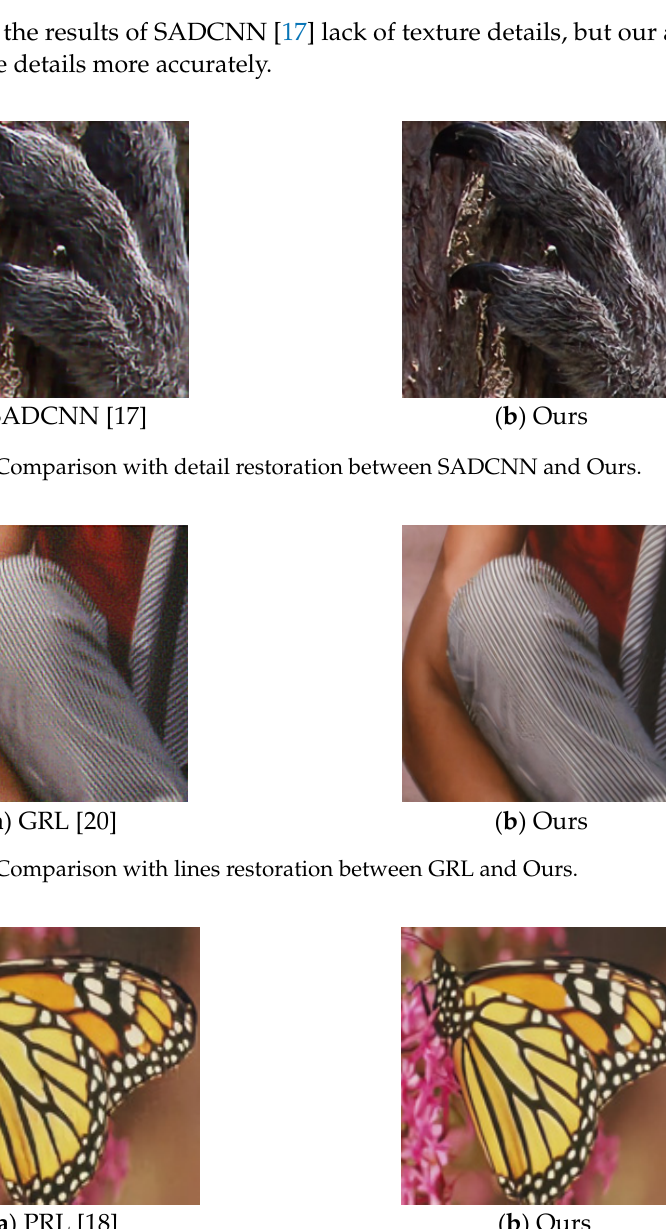
Figure 9. Comparison with texture restoration between PRL and Ours.